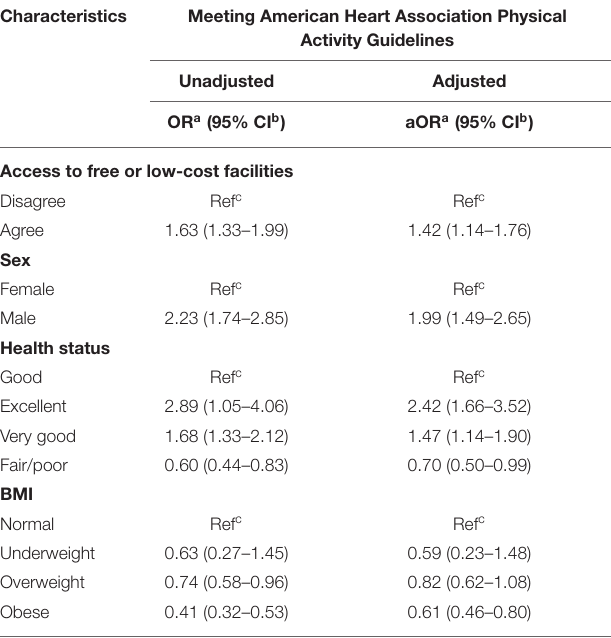
TABLE 2 | Unadjusted and adjusted association between access to free or low-cost recreational facilities and meeting the American Heart Association’s Physical Activity Guidelines for Americans, 2017 FLASHE